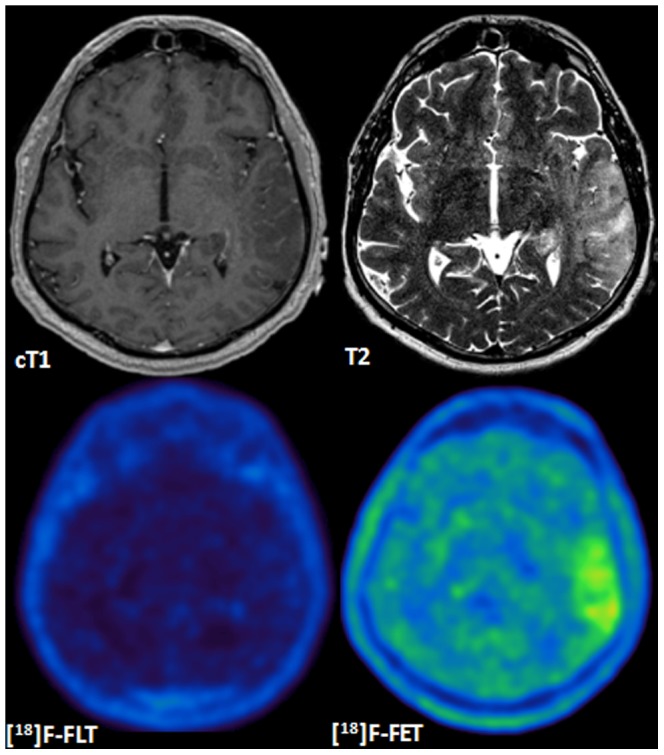
MRI and PET in a patient with non-enhancing GBM WHO IV.Newly diagnosed GBM WHO IV presenting with a hyperintense T2 lesion left parieto-temporal but without contrast enhancement on cT1. In contrast to the absence of [18F]-FLT tracer uptake, a metabolically active lesion can clearly be depicted on [18F]-FET PET.